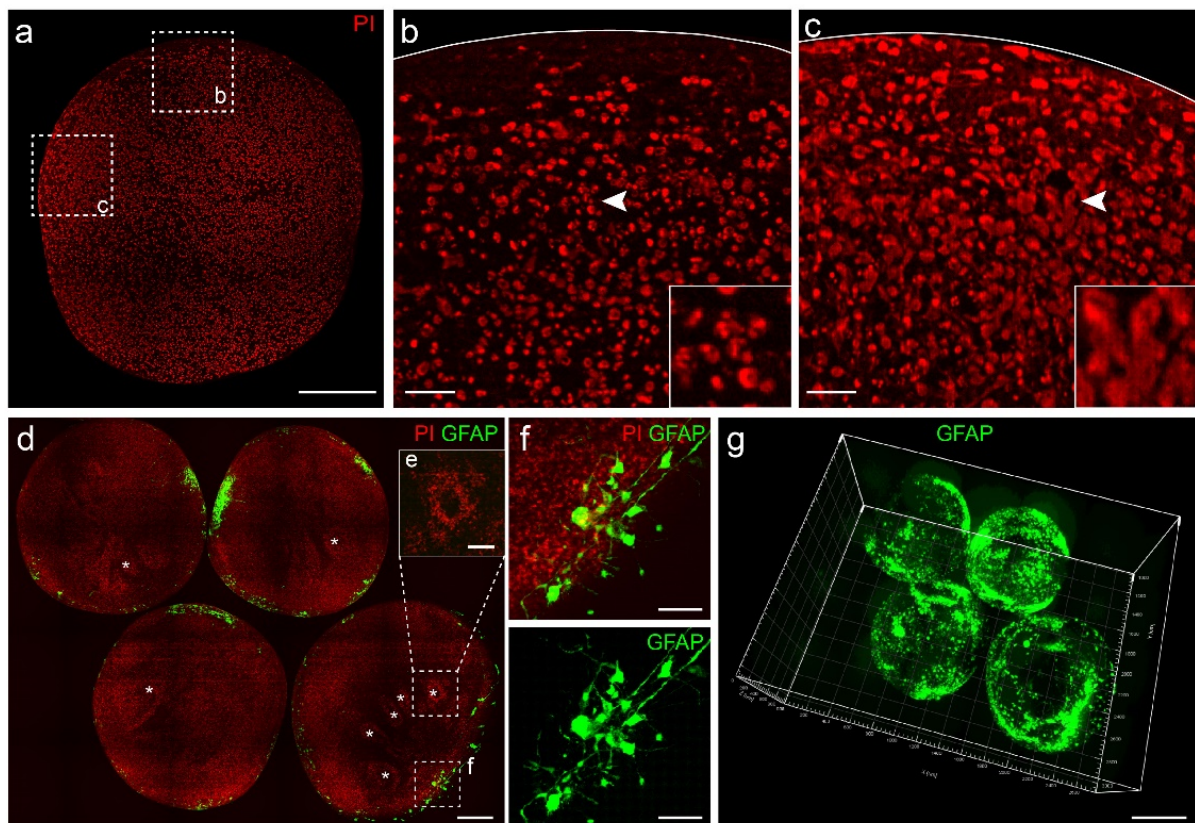
Figure 3. PI staining results and comparison of multiple organoids. ( a ) Maximum intensity z-projection of a 2- µ m-thick section of a PI-stained organoid. Scale bar: 200 µ m. ( b , c ) Higher magnifications of specified regions in a. Arrows indicated the location of enlarged views. Scale bars: 25 µ m. ( d ) Standard deviation z-projection of a 60- µ m-thick section of an array of organoids. Asterisks indicated rosette-like structures ( e ). Scale bar: 200 µ m. ( f ) Higher magnifications of the specified region in d. Scale bar: 50 µ m. ( g ) 3D reconstruction of GFAP + cells in the array of multiple organoids from ( d ). Scale bar: 500 µ m.